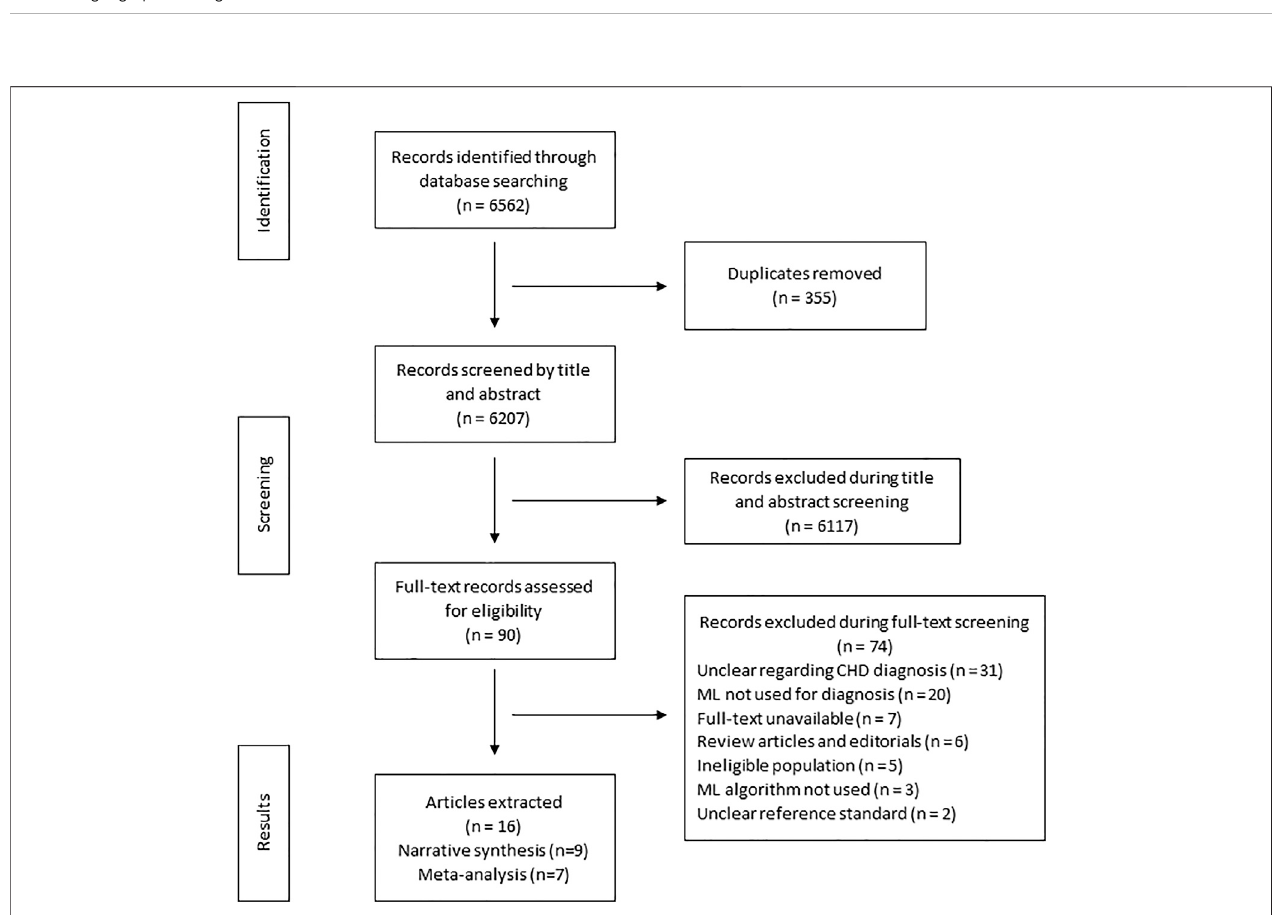
FIGURE 1 | Search fl ow